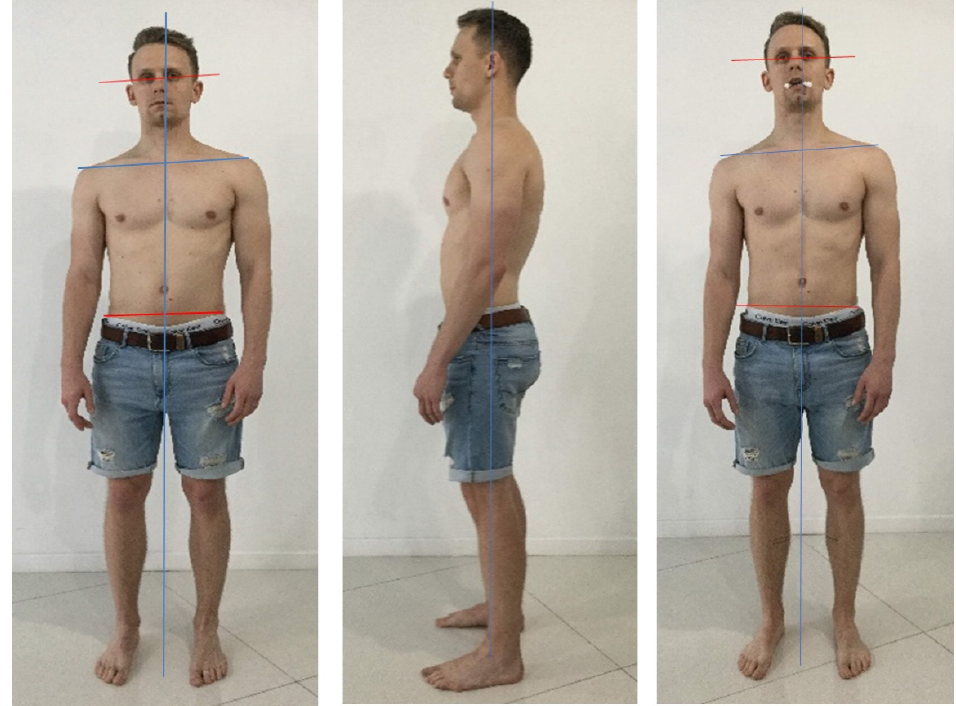
Figure 29. A 28-year-old patient with pain (5/10) and nonspecific muscle weakness in the right hip, evaluated by active hip flexion (pain) and unipodal balance (weakness). The informed consent from the patient was obtained for publication of photos. Source: Rocabado Institute, Chile. Note the misalignments at the shoulders (most evident), and the pelvis (less evident, however, the object of our intervention). The head is presented in the side bending/rotation to the right, and forwarded. The body posture is reassessed in both planes, this time avoiding occlusal contact with a soft disposable element. Although the shoulder misalignment is maintained, soft changes at the pelvic level can be seen: hip flexion’s pain is 1-2/10 (lower), and unipodal stability improves subjectively, although weakness persists. There are no significant changes in the sagittal plane. Such clinical findings lead us to consider the management of local conditions that are not necessarily the cause, but rather the consequence of alterations in complex kinematic chains to be considered, to increase the effectiveness of interventions, combining dentistry and physiotherapy in such clinical situation’s